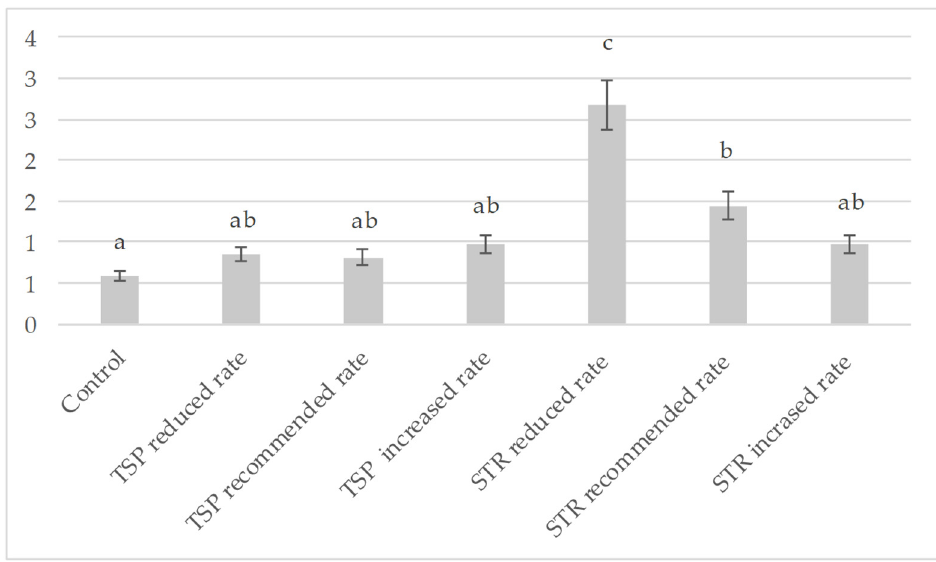
Figure 10. Copper content in the peat (mg kg − 1 D.M) as affected by the interaction of examined factors (A × B) at the level of significance α = 0.05 ( p value < 0.01).